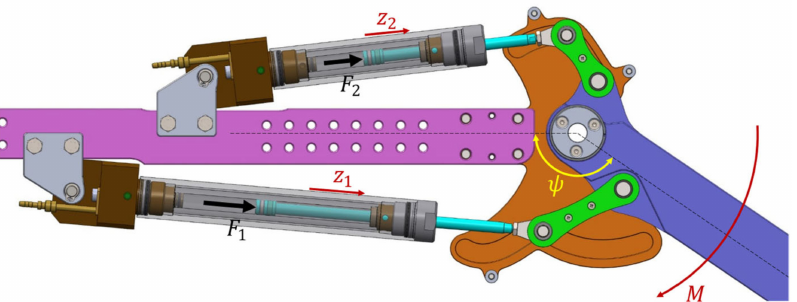
Figure 3. Illustration of the piston positions ( z 1 , z 2 ), knee angle ( ψ ), cylinder forces ( F 1 , F 2 ), and knee torque ( M